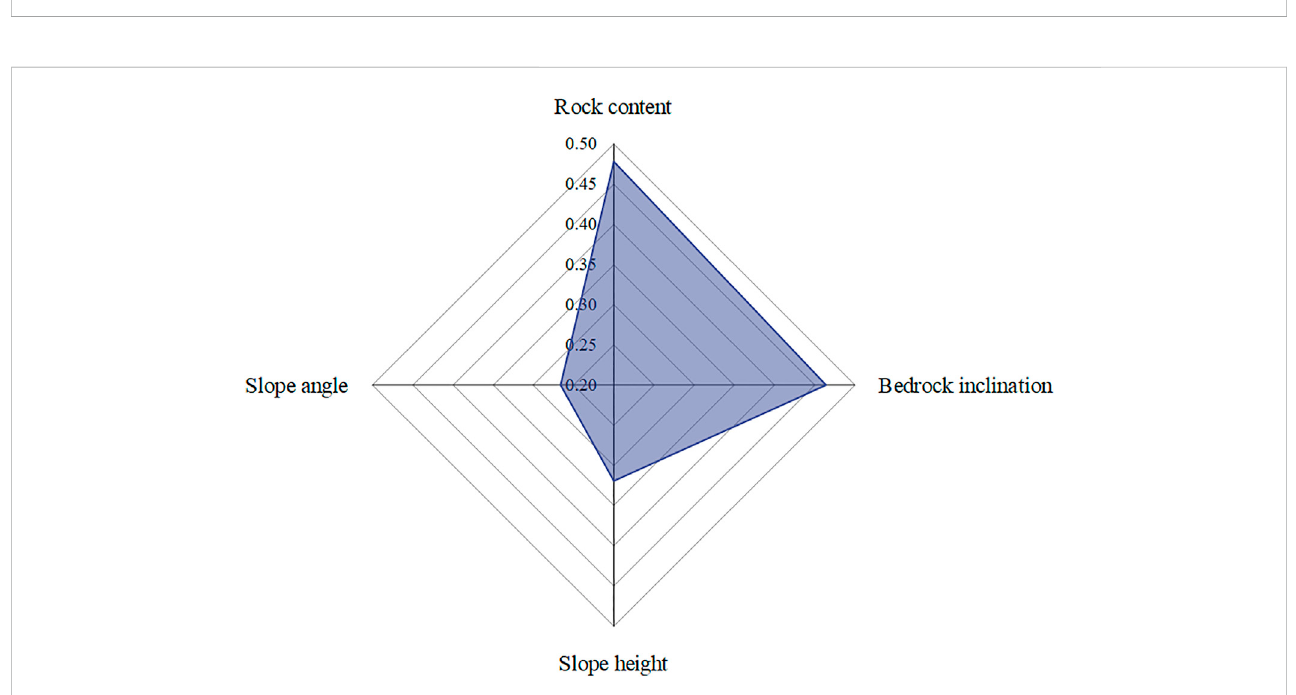
FIGURE 9 The Permutation Importance value of input